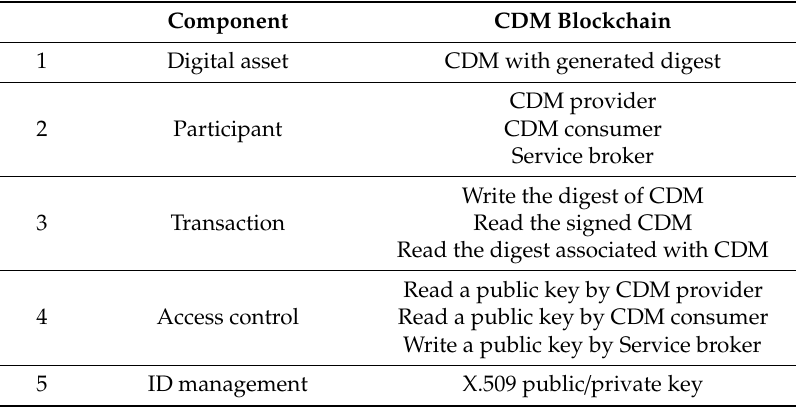
Table 1. The basic definition of the components of CDM blockchain.